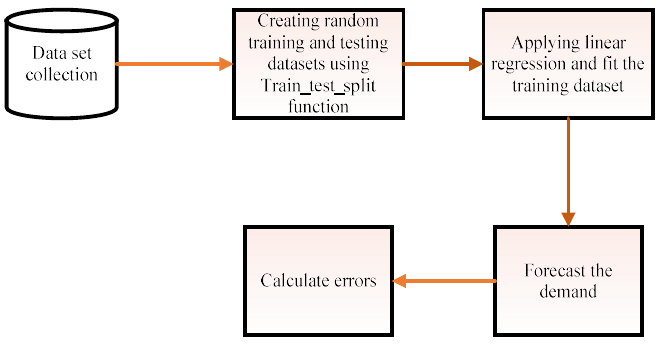
Figure 4. Architecture of linear regression.